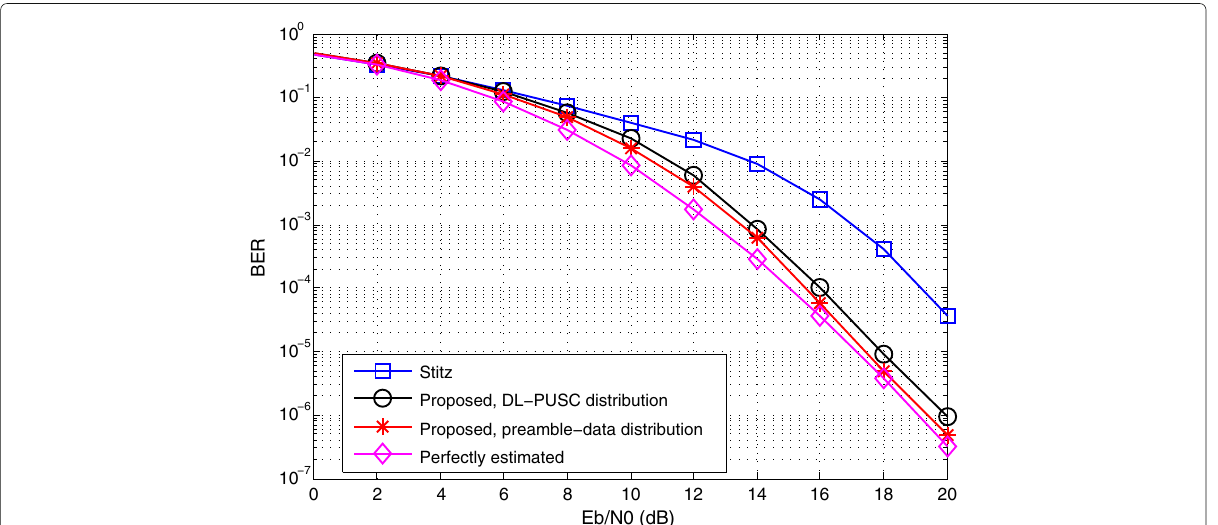
Fig. 7 Comparative coded BER versus input E b / N 0 in the presence of CFO, STO and channel estimation